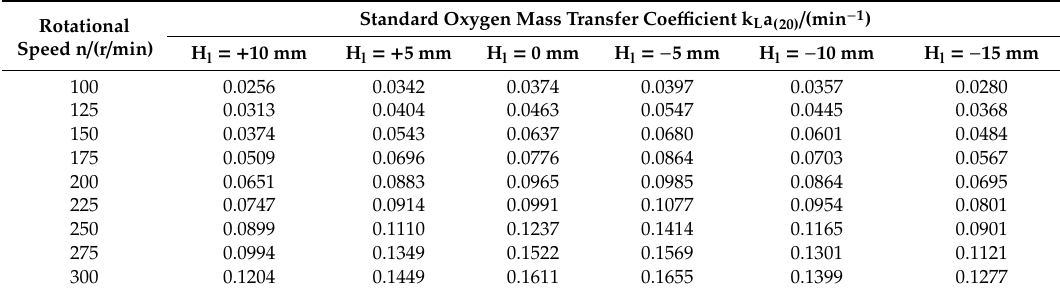
Table 4. Standard oxygen mass transfer coefficient. Rotational Speed n/(r/min)